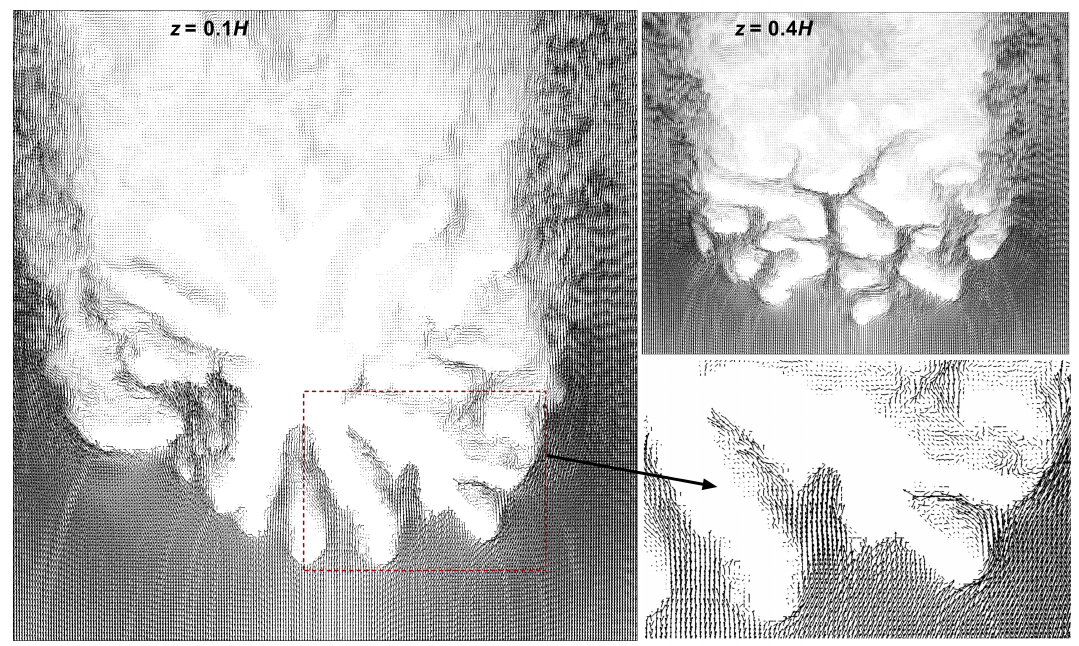
Figure 5. Top view of the instantaneous velocity vector fields at two different heights ( z = 0.1 H and 0.4 H , where H is the height of the colony) inside the P. meandrina colony. These vector fields show the detailed interaction of the oncoming flow with the individual branches of the colony. The lower right figure shows a zoomed-in view of the velocity vectors at the frontal section of the colony at z = 0.1 H . The difference in vector fields at the front and rear halves of the densely branched coral, P. menadrina is clearly observable from the